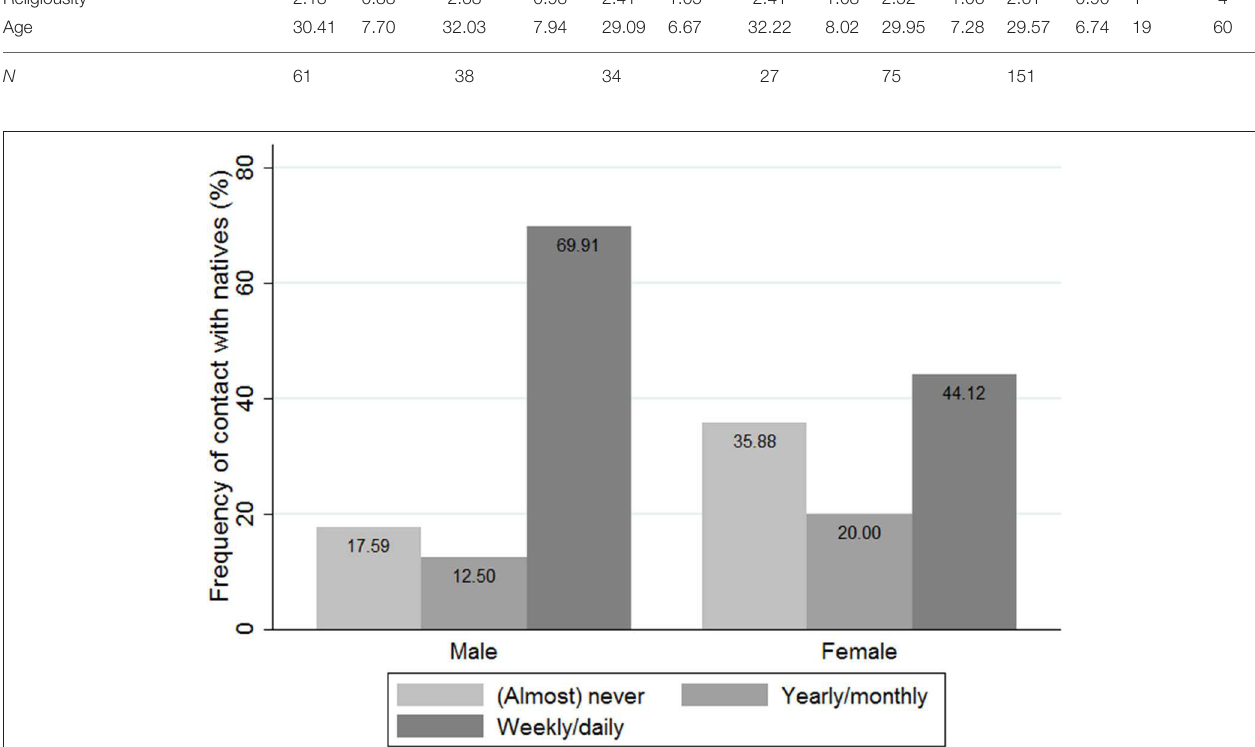
The descriptive statistics already indicate gender differences in contact to natives. In the following I examine potential explanations for this gender gap. I conduct a